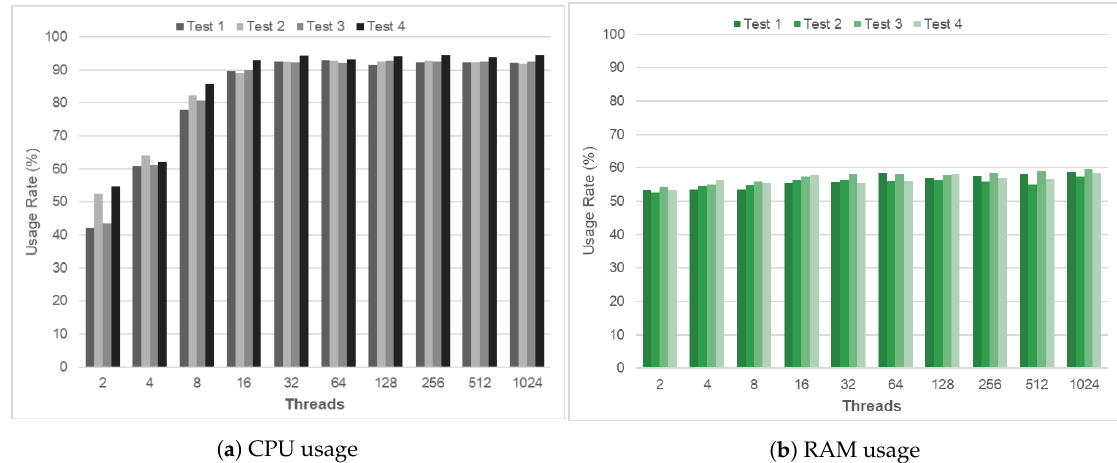
Figure 5. Evaluation of platform